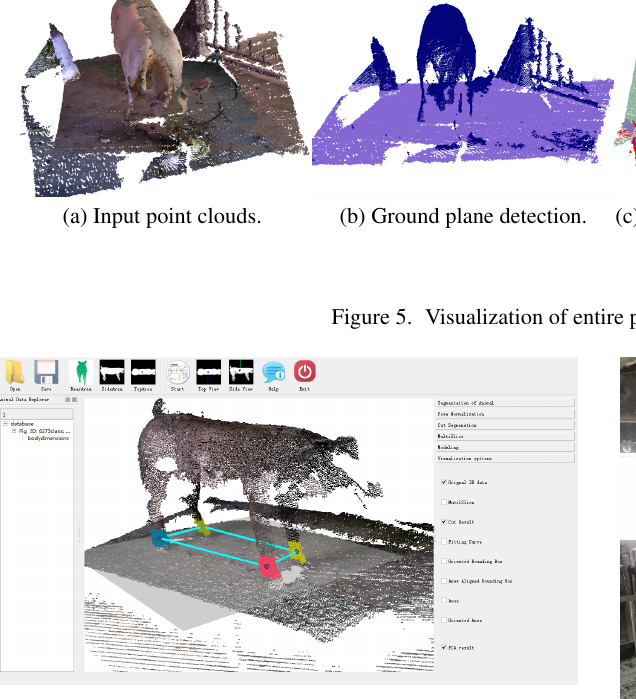
Figure 6. Geometric elements extraction results on the data of Fig.4. Note that semi-transparent grey plane represents the horizontal plane P h , four colored clusters indicate { h 1 , · · · , h 4 } while four small semi-blue spheres represent the mass centers. Figure 8. The final setup of our 3D scaning system for live Quadrilateral with cyan color is final output of geometric element extraction.